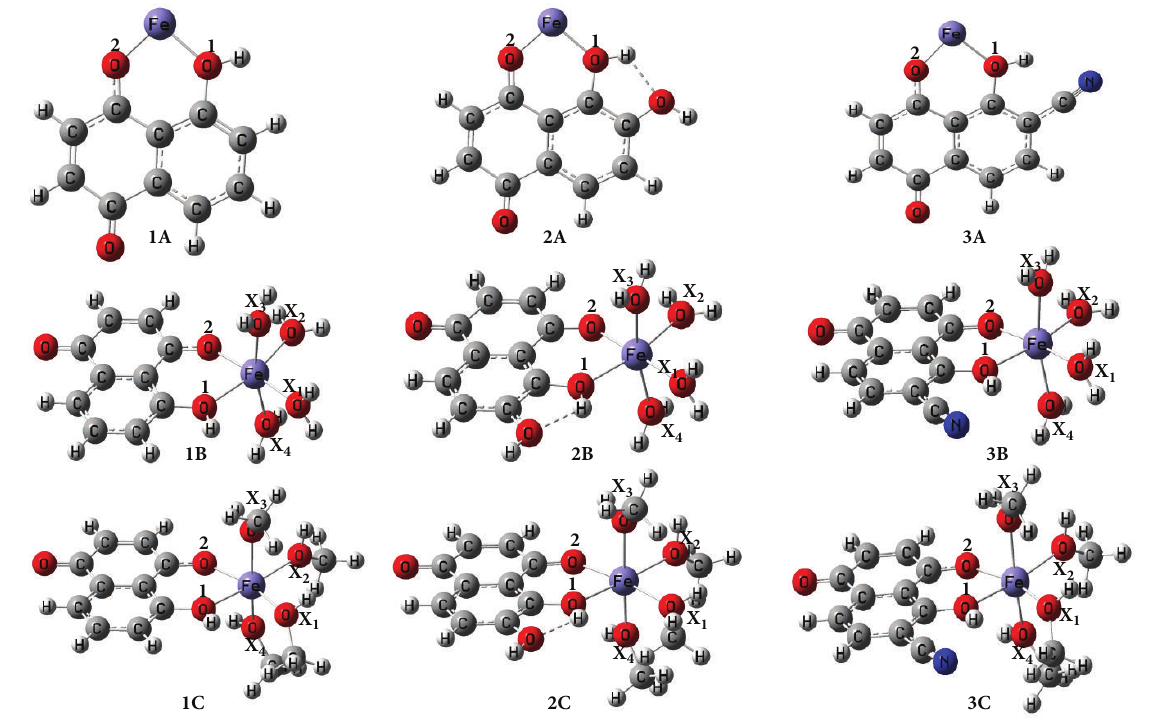
Figure 1: Optimized geometries of the studied molecules, obtained by applying the B3LYP/6-31G(d)(Fe)U6-31+G(d,p)(E) level of theory.